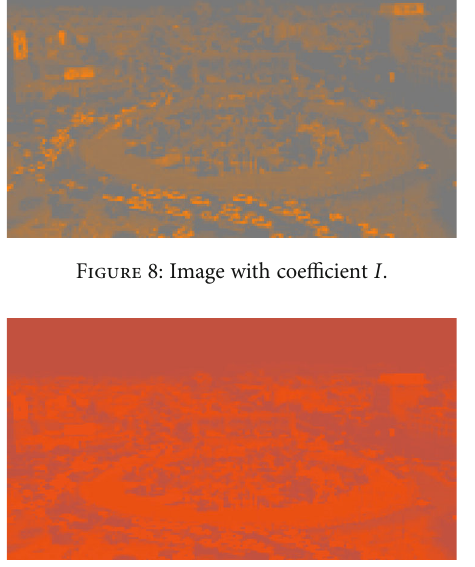
Figure 9: image with coe ffi cient Q